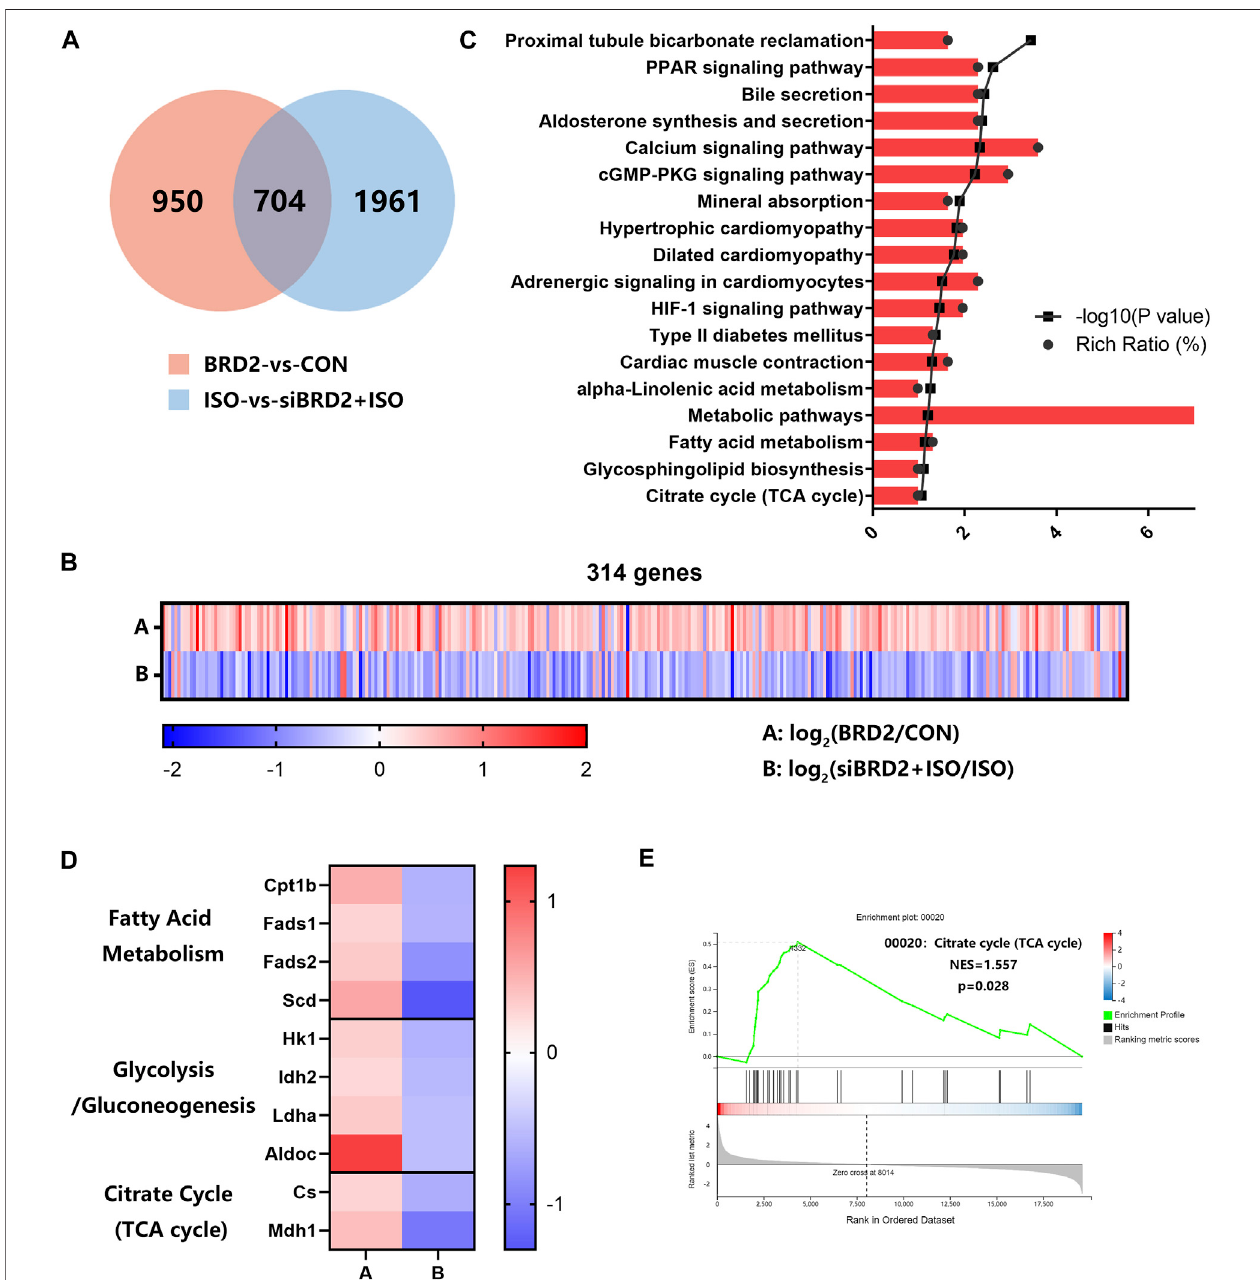
FIGURE 4 | RNA sequencing analysis of transcriptome changes in NRCMs with BRD2 overexpression or silencing. (A) Venn diagram showing genes differentially expressed between “ BRD2 vs. CON ” and “ siBRD2+ISO vs. ISO ” groups (|log 2 FC| ≥ 0.5, Q value ≤ 0.05). (B) Heatmap showing differentially expressed genes between “ BRD2-vs-CON ” and “ siBRD2+ISO ” vs. “ ISO ” groups (|log ≥ 0.5, Q value ≤ 0.05). (C) KEGG pathway analysis of 314 genes regulated by BRD2 (|log 2 FC| value ≤ 0.05). (D) HeatmapshowingthedifferentiallyexpressedmetabolicgenesunderregulationbyBRD2accordingtotheRNA-seq